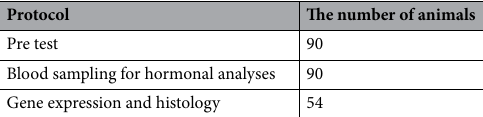
Table 1. Number of animals used for each